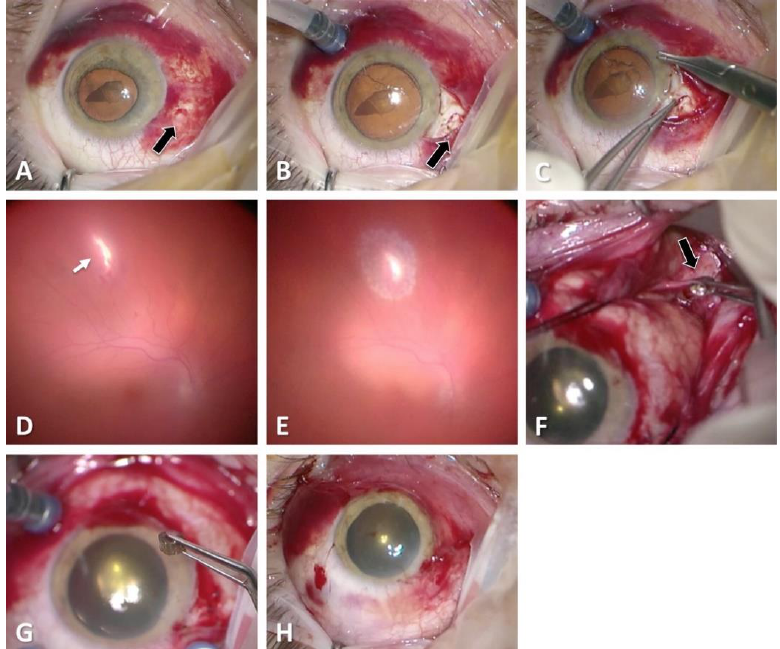
Figure 4. Zone III perforating open globe injury: Preoperative findings of the anterior segment with a self-closed entry of the foreign body 2 mm posterior the corneoscleral border (black arrow) ( A–C ). Vitrectomy and intraoperative situation ( D , E ): After removing the vitreous hemorrhage, a secondary posterior laceration is revealed (white arrow). The foreign body is not detectable from inside. Additional opening of the conjunctiva and inspection of the posterior sclera ( F ). Removal of the foreign body located at the posterior pole (black arrow) ( F ). End of surgery ( G – H